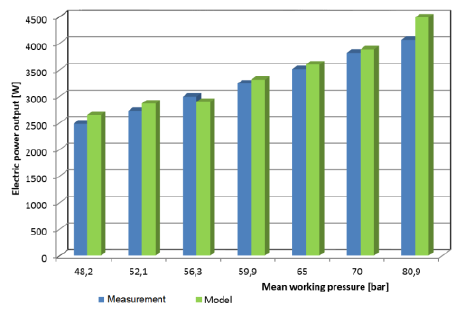
Fig. 5 Comparison between model and